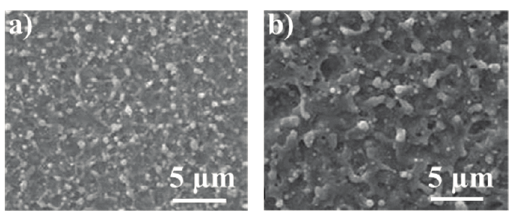
Figure 4. Increasing fluence increases feature sizes of nanostructures on Ni,